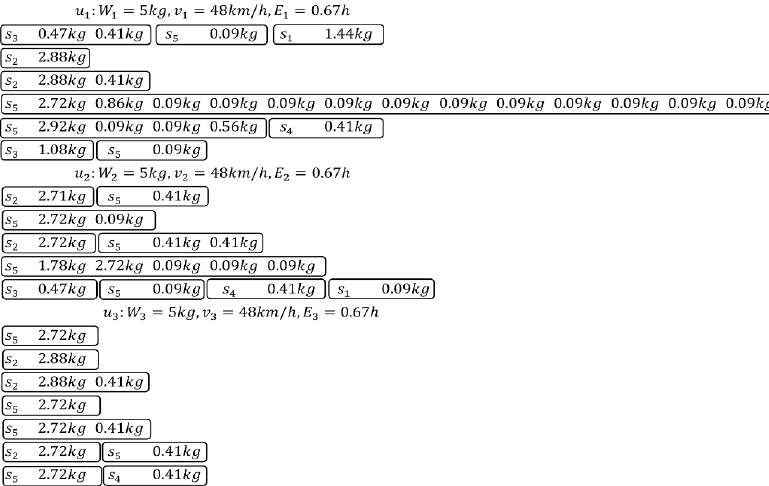
Figure 7. Small scale experimental results of UAV path planning.